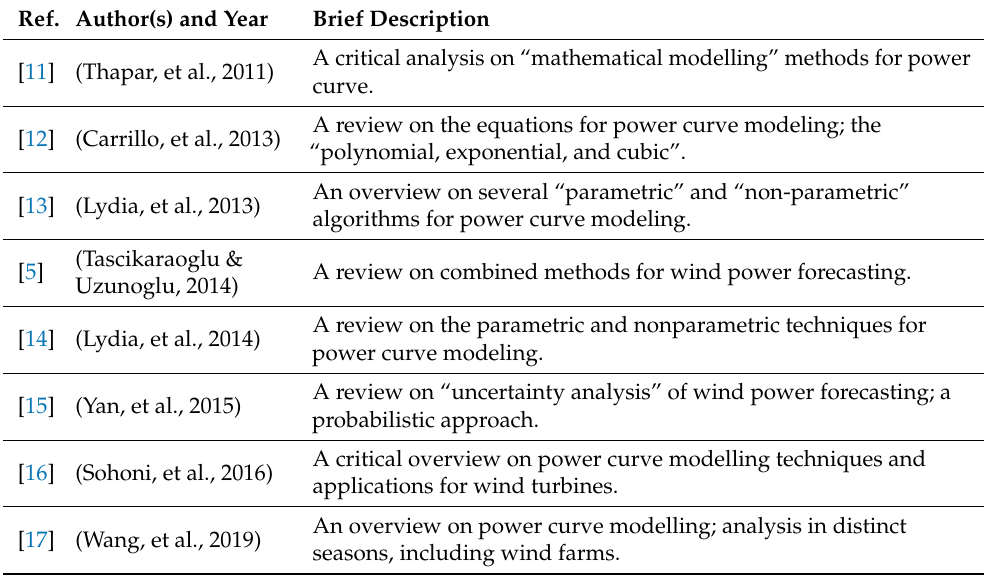
Table 1. Available reviews on power curve modeling and